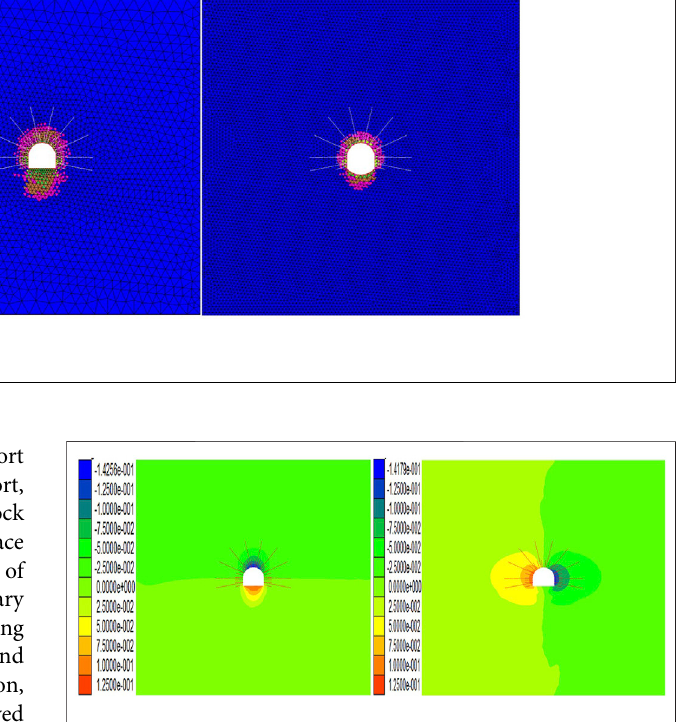
FIGURE 12 | Displacement of the anchor rope (rod) support.